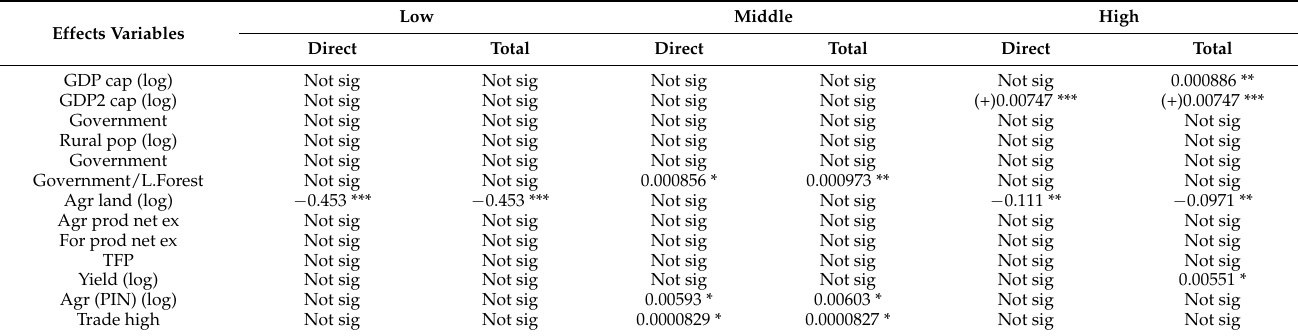
Table 10. Assessment of indirect effects, income